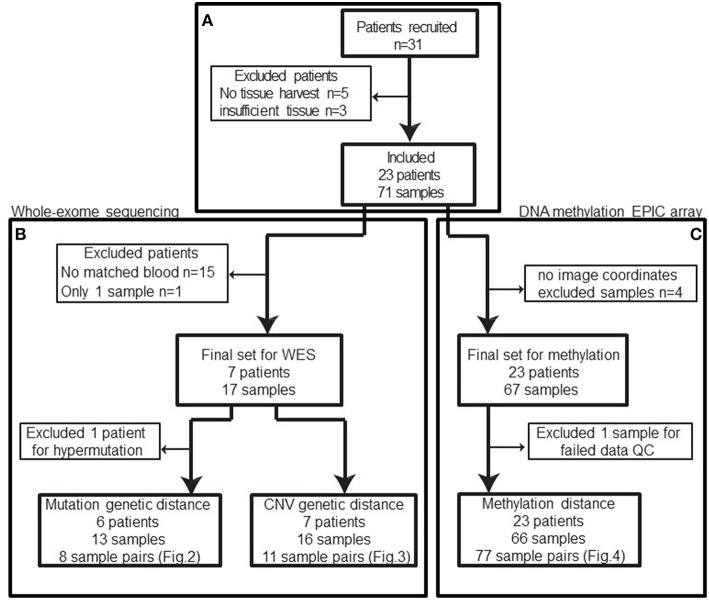
Patient and samples cohort processing flowchart. (A) 31 patients were recruited between 2013 and 2016. Five patients had no tissue harvest due to surgical complexity (n = 3), cardiac issues, or technical difficulties and three patients had no sufficient tissue. In total, eight patients were excluded from the cohort. (B) Among the remaining patients, only eight patients had normal blood samples available for whole-exome sequencing and one of those patients only had a single sample sequenced. Based on the mutation calls, one patient was excluded due to abnormally high mutation burden (TMB). The remaining 13 biopsies from 6 patients constitute 8 biopsy pairs for mutation genetic distance. (C) After excluding samples without image coordinates, we have 67 samples from 23 patients for methylation profiling. One sample was excluded from methylation analysis due to poor data quality: 12.85% of available probes returned missing values. In summary, 66 samples from 42 unique image guided biopsy sites in 23 patients were available for methylation data analysis, comprising 77 unique biopsy pairs. The specific patients included in each analysis is available in Table 1.